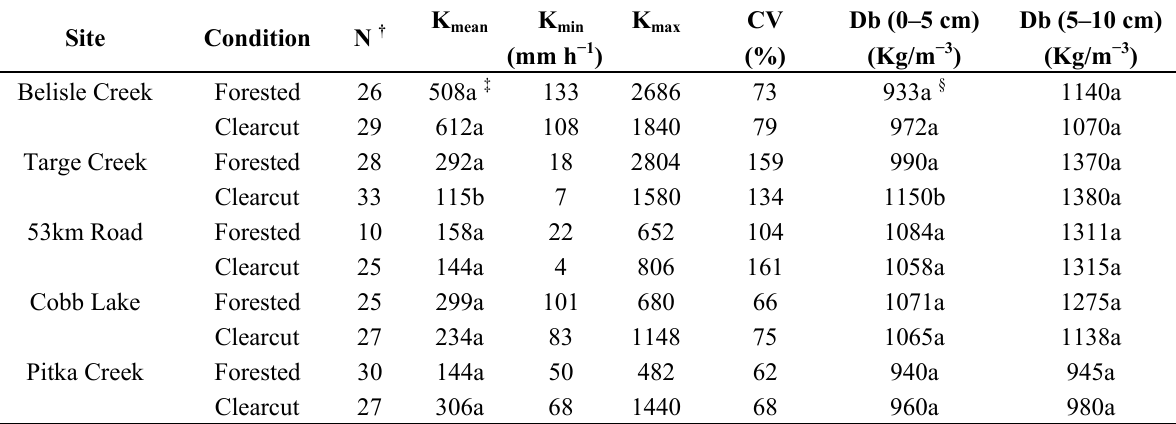
Table 5. Comparison of saturated hydraulic conductivity (Ksat) between forested and clear-cut areas for the five selected sites. Kmean is geometric mean Kfs value, Kmax is maximum Kfs value, Kmin is minimum Kfs value, CV is coefficient of variation, and Db is soil bulk